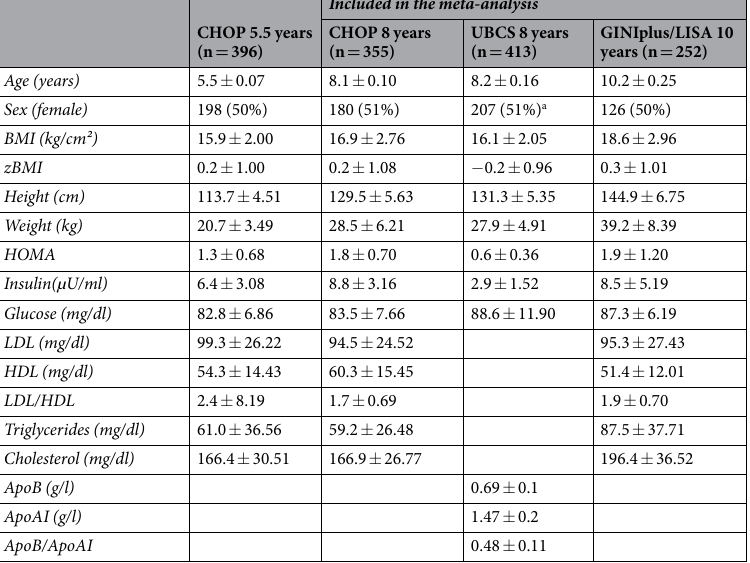
Supplemental Table 2. Except for tyrosine, valine, free carnitine and SM 32:2, all metabolites were associated with BMI z-score in one population only.